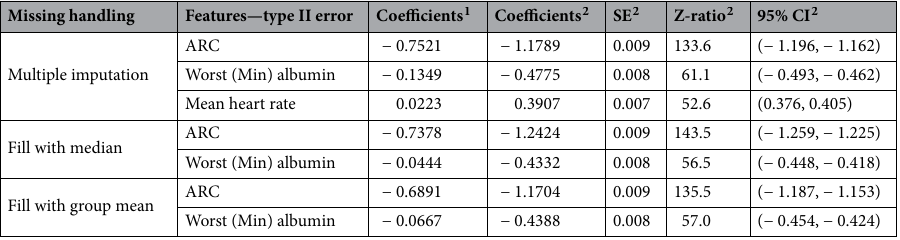
Table 3. Features selected for Type II error when using cutoff 0.33. 1 Coefficients calculated from fitting the Lasso feature selection model. 2 Coefficients, SE, Z-ratios, and the 95% CIs calculated by ordinary logistic regression using the selected features from Lasso; Features sorted by Z-ratios, where Z-ratio = | Coefficient / SE | .